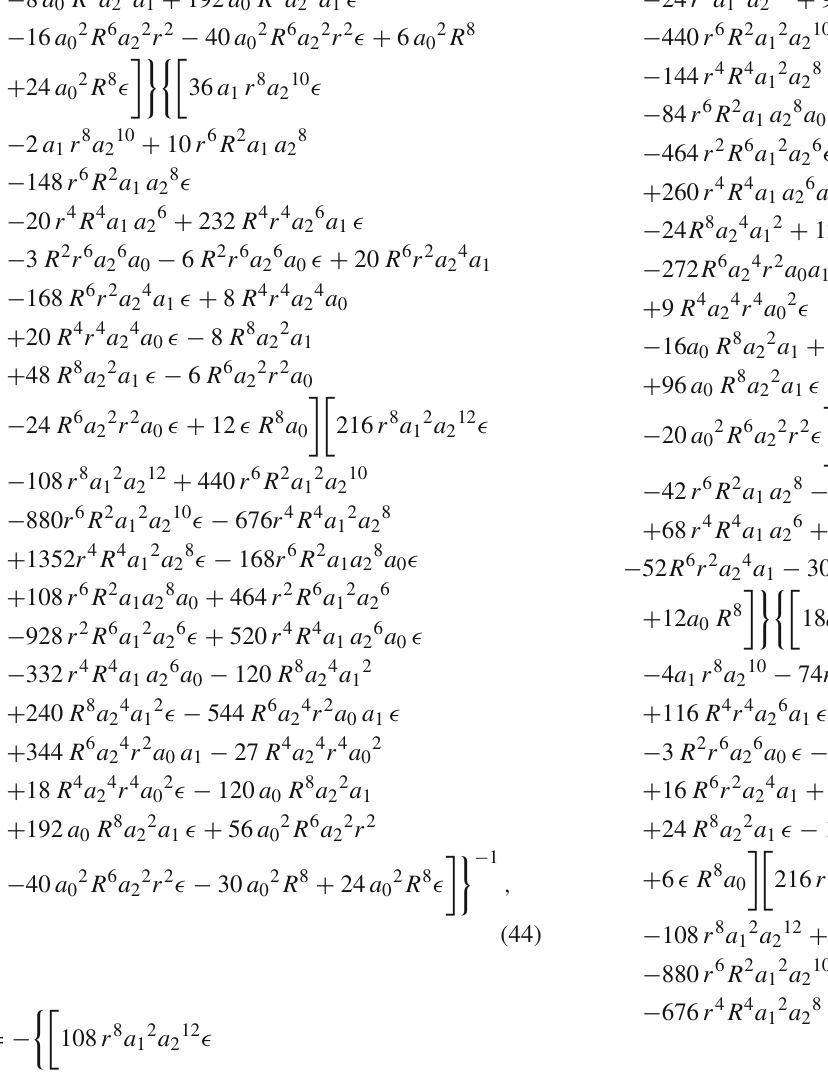
Fig. 8 Plots of the Adiabatic indices γ , Γ r and Γ t , namely (43)–(45), versus the radius r using the constants constrained from Her X-1 . For RT, the adiabatic index γ less than the GR case but still greater than the 8 a 22 a 8 a 22 a − 8 a + 192 a 0 R 1 0 R 1